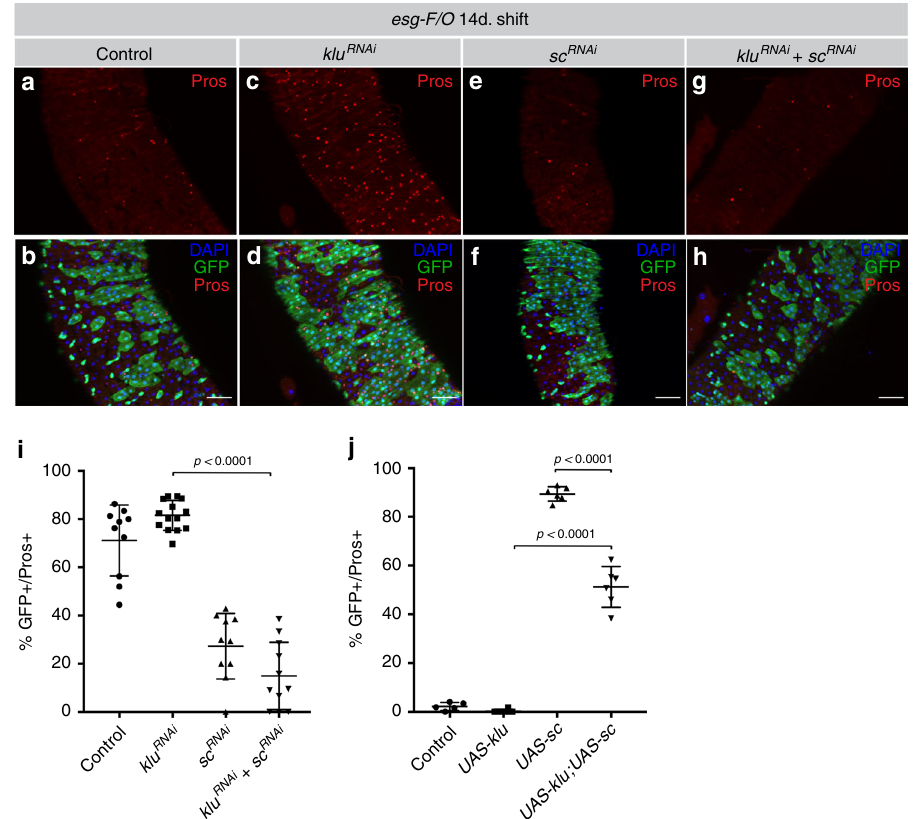
Fig. 6 Scute acts downstream of Klu in enteroendocrine differentiation. a , b Control esg-F/O clones 14 days after clonal induction. c , d Expression of klu RNAi lead to increased EE differentiation in clones, marked by increased numbers of Pros + -cells (red) ( c , d , quanti fi cation in i , j ). e , f sc RNAi clones showed almost no EE differentiation. g , h Similarly, the combination of klu RNAi with sc RNAi resulted in clones lacking EE differentiation. Representative areas of posterior midgut are shown. i Quanti fi cation of GFP + /Pros + double-positive cells/clone of the genotypes in a – h . n = 10 for control, n = 14 for klu RNAi , n = 10 for sc RNAi and n = 12 for sc RNAi ;klu RNAi . j Quanti fi cation of GFP + /Pros + double-positive cells/clone of esg-F/O clones expressing either UAS-sc , UAS-klu , or the combination. See Supplementary Fig. 7 for images. n = 5 for control, n = 6 for UAS-klu , UAS-sc , and UAS-klu ; UAS-sc . Error bars represent mean ± SD. Signi fi cance was calculated using Student ’ s t -test with Welch ’ s correction. Scale bar = 50 µ